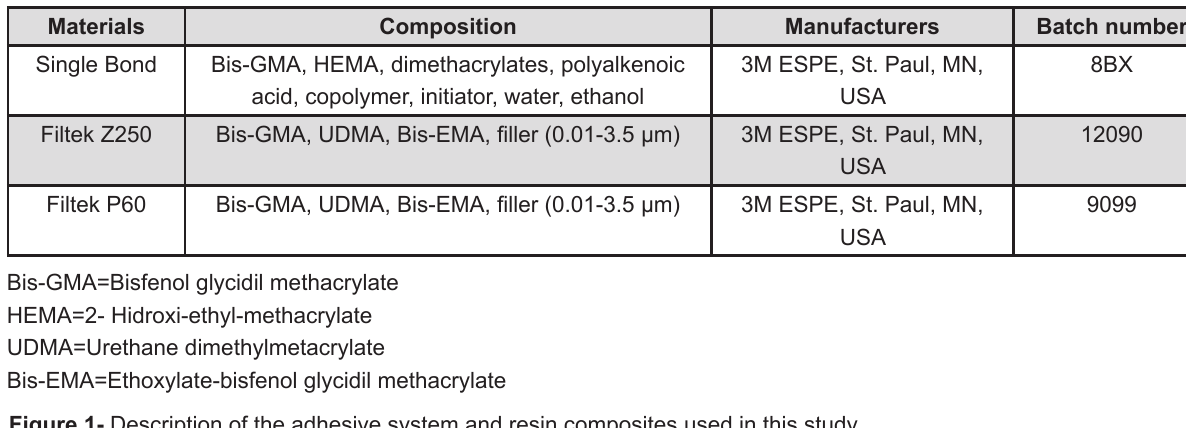
Figure 1- Description of the adhesive system and resin composites used in this study